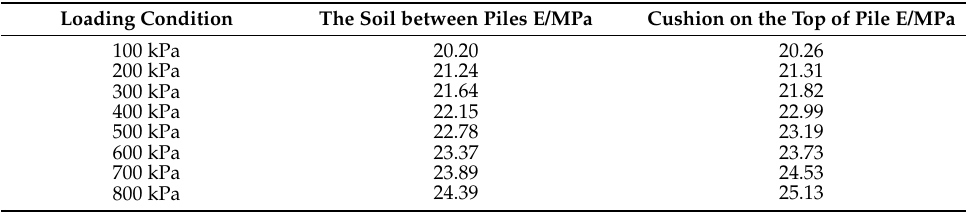
Table 3. Nonlinear elastic modulus of cushion and the soil between piles of test-1.